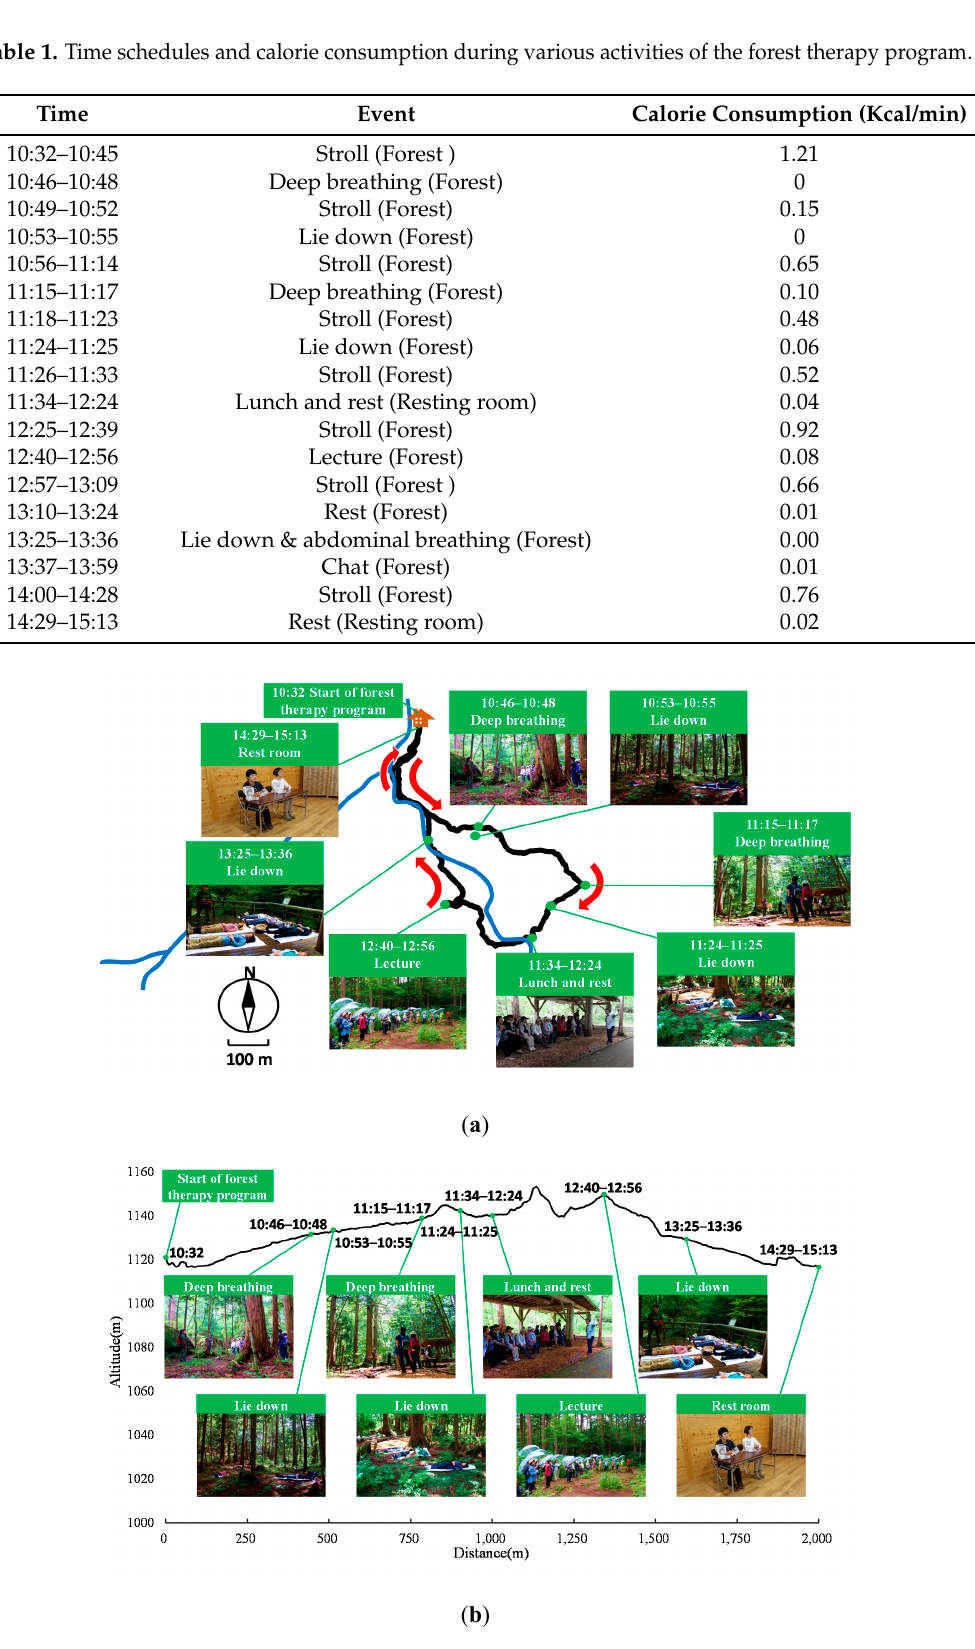
Figure 1. Images showing the various activities of the forest therapy program with location map. ( a ) : plane map, ( b ): altitude map.